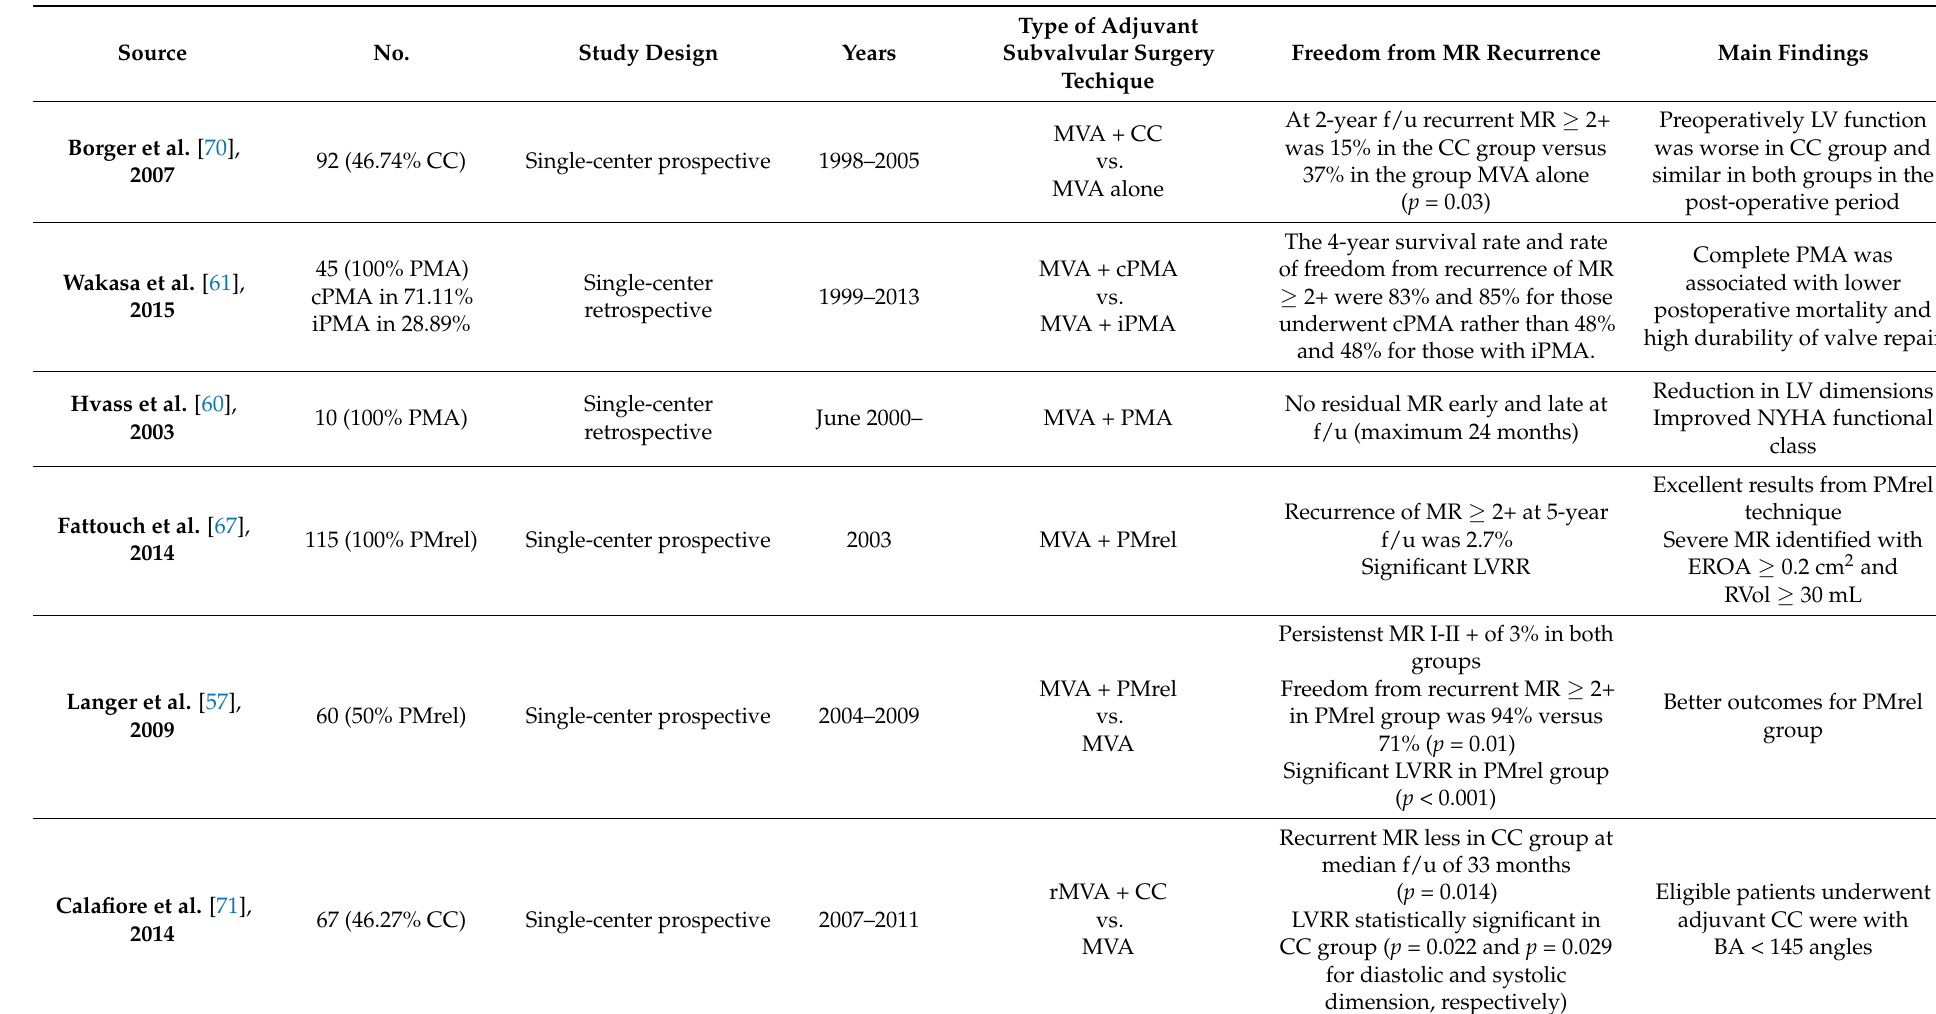
Table 3. Findings from major studies evaluating the effectiveness in terms of freedom from mitral regurgitation recurrence and left ventricular reverse remodeling after adjuvant sub-valvular surgery in the management of severe IMR, further reporting analyzed clinical